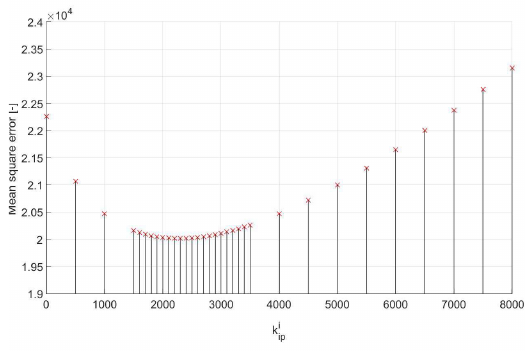
Figure 8. Residual sums of control functions with variable k i across all recordsets. ip